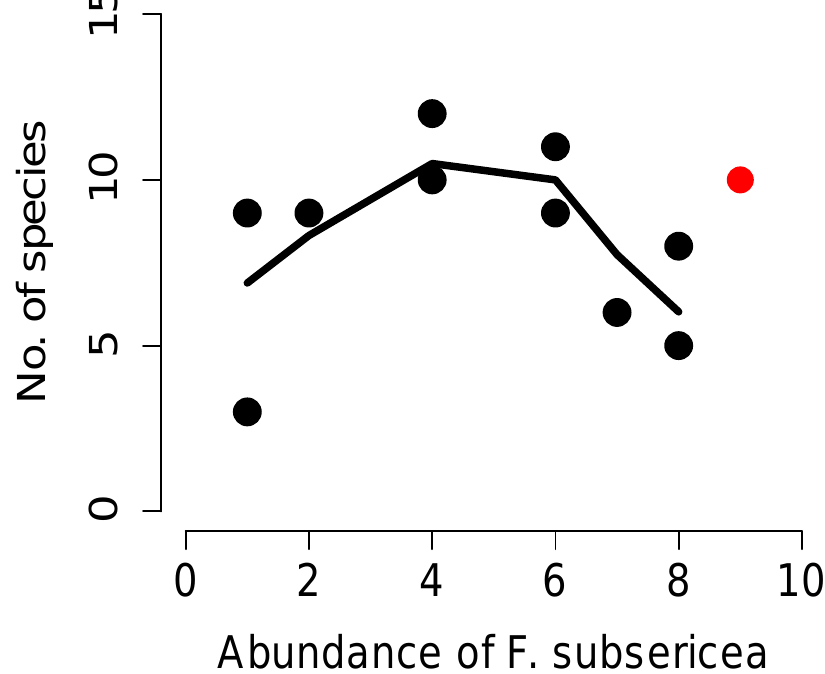
Figure 1. The unimodal relationship between the richness of non-dominant ant species recorded in pitfall traps at a site and the number of pitfall traps in which a dominant F. subsericea was recorded. The relationship is statistically significant only if the outlying point in red is